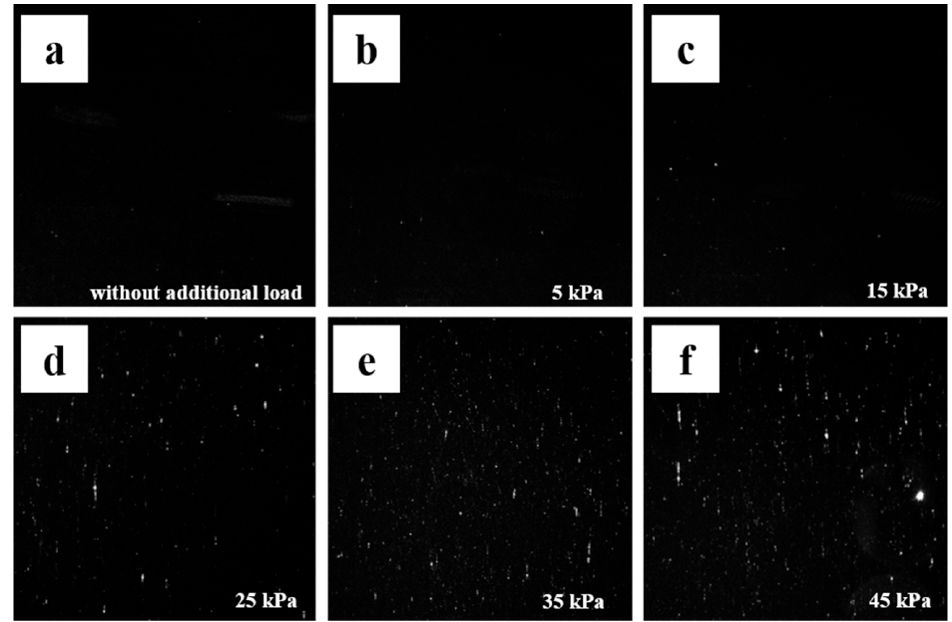
Figure 11. Typical defect distribution diagram of components under different additional loads ( a ) zero load; ( b ) 5 kPa; ( c ) 15 kPa; ( d ) 25 kPa; ( e ) 35 kPa; ( f ) 45 kPa. load; ( b ) 5 kPa; ( c ) 15 kPa; ( d ) 25 kPa; ( e ) 35 kPa; ( f ) 45 (2) Effect of abrasive hardness on surface defects.